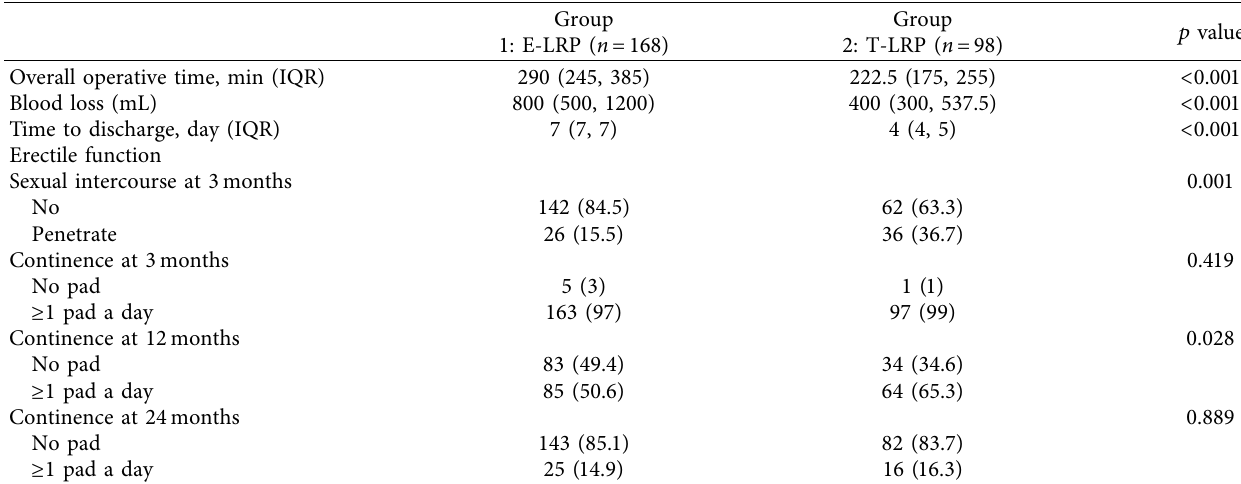
Table 2: Comparison of perioperative data. Group